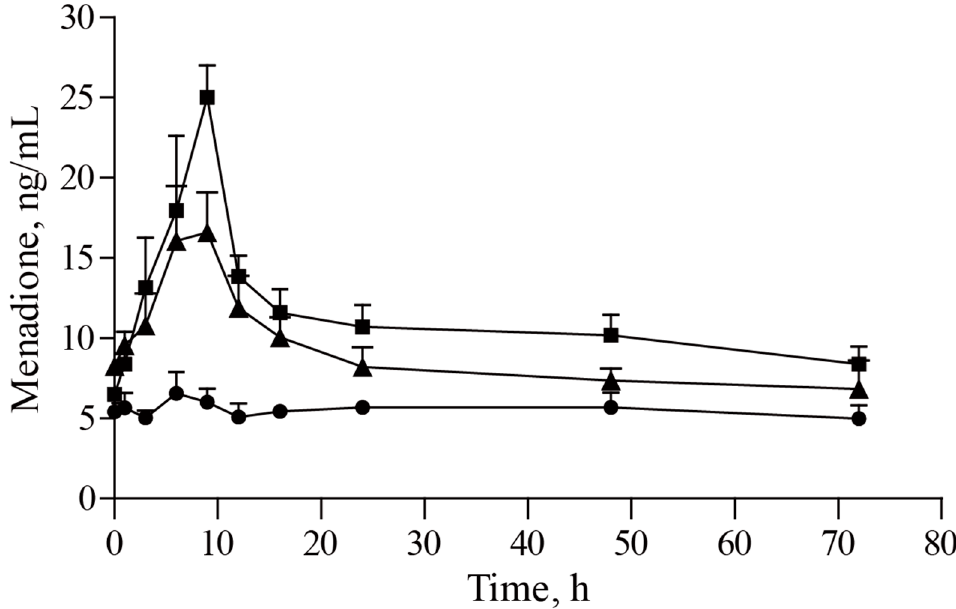
Figure 3. The plasma concentration of α -tocopherol versus time. The concentration of α -tocopherol in plasma from 0 to 72 h after oral placebo ( ● ), non-microencapsulated vitamin supplement ( ▪ ), and microencapsulated vitamin supplement ( ▲ ), respectively. Error bars represent standard deviations.